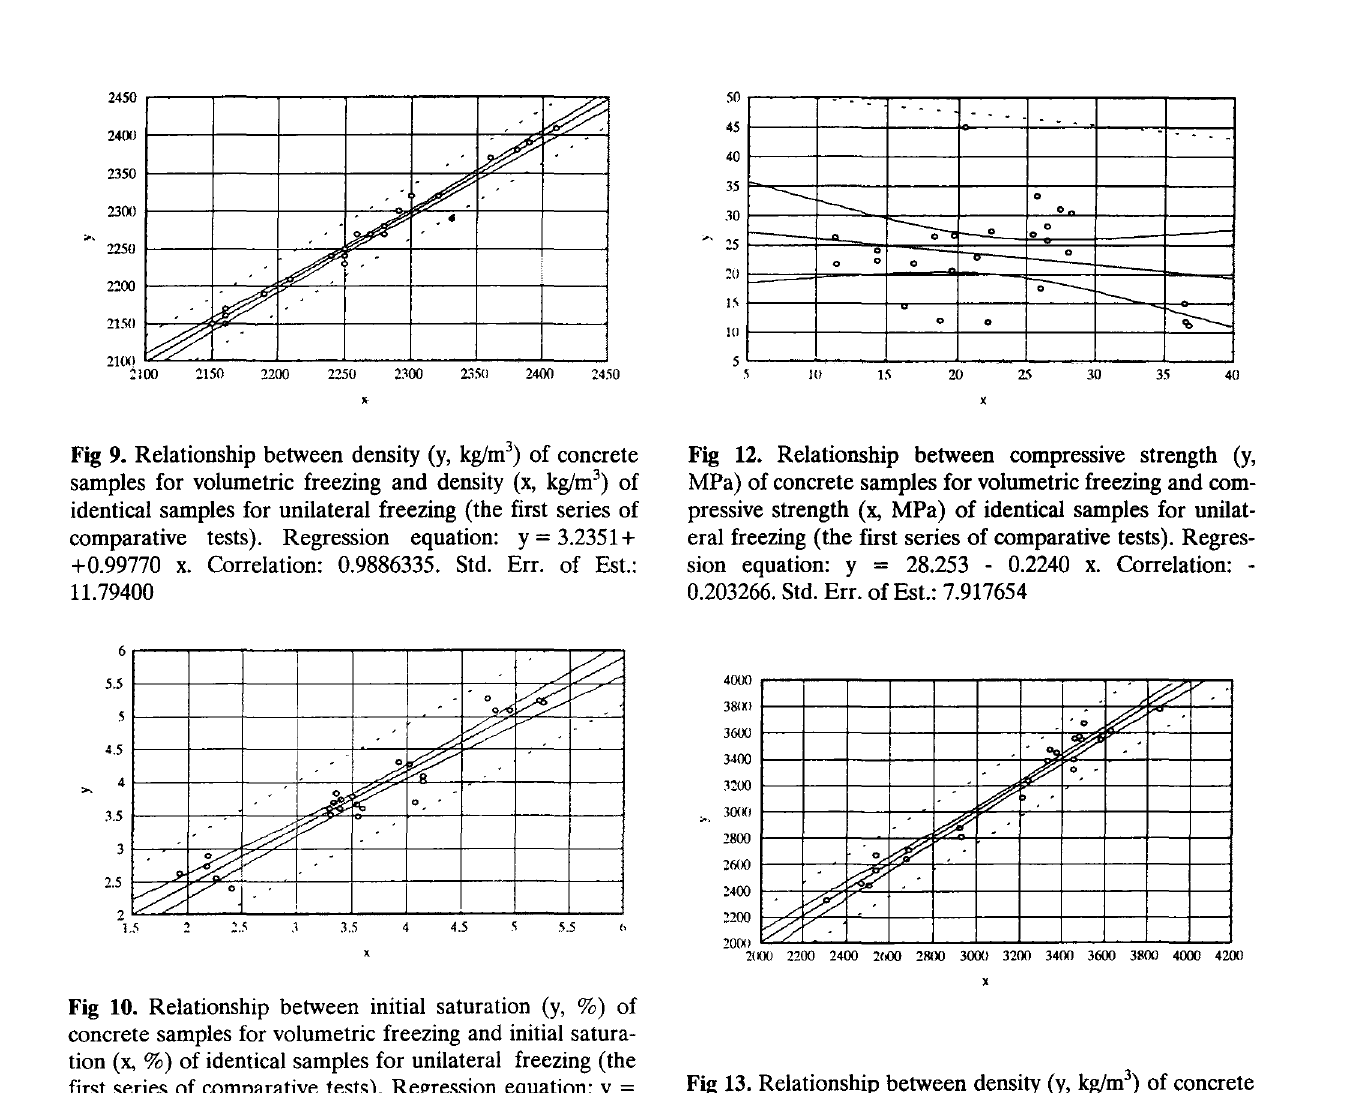
Fig 13. Relationship between density (y, kg!m 3 ) of concrete samples for volumetric freezing and density (x, kg!m 3 ) of identical samples for unilateral freezing (the second series of comparative tests). Regression equation:y = 10.698 + 0.99814 x. Correlation: 0.9849783. Std. Err. of Est.: